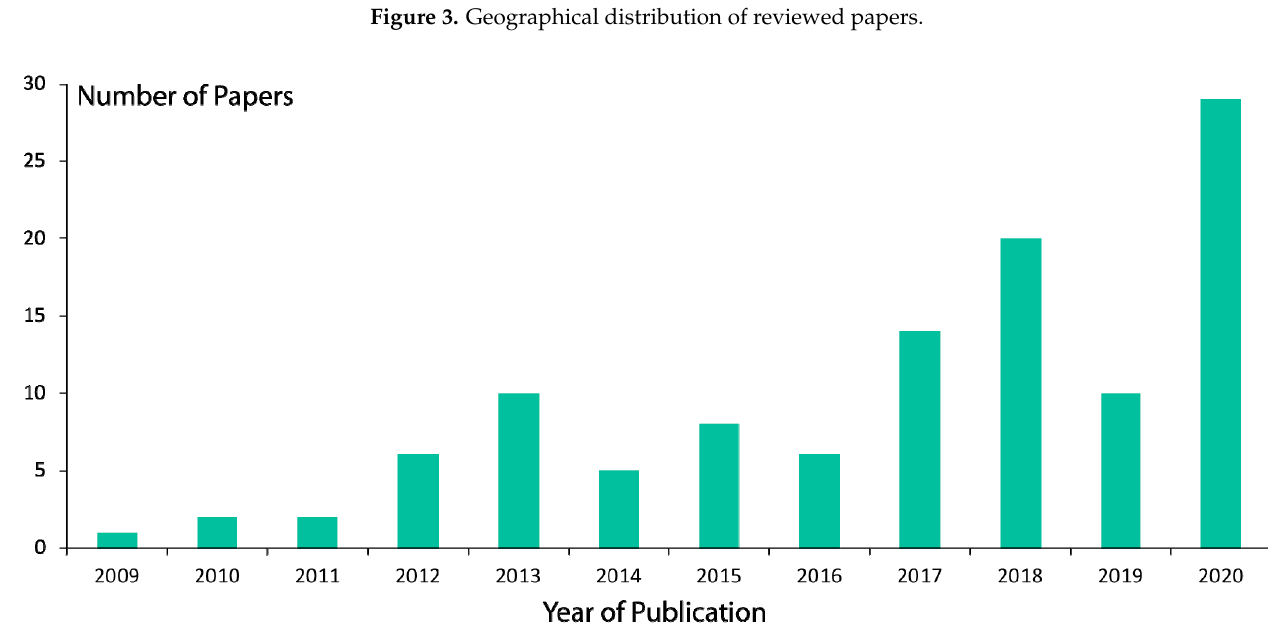
Figure 4. Temporal distribution of review papers.